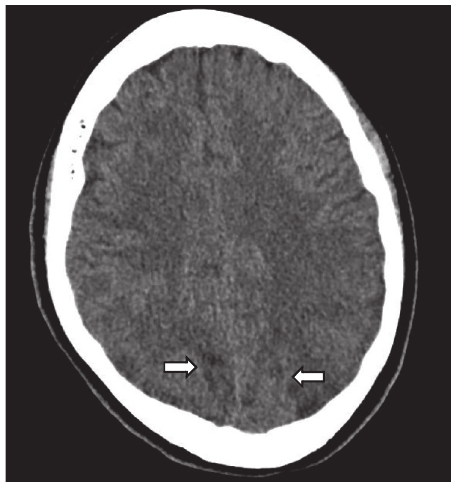
Figure 1: Axial computed tomography image revealing patchy hypodensity in the posterior parietal and occipital lobes, right greater than left. There are few tiny foci of hyperdense hemorrhage seen in areas of edema